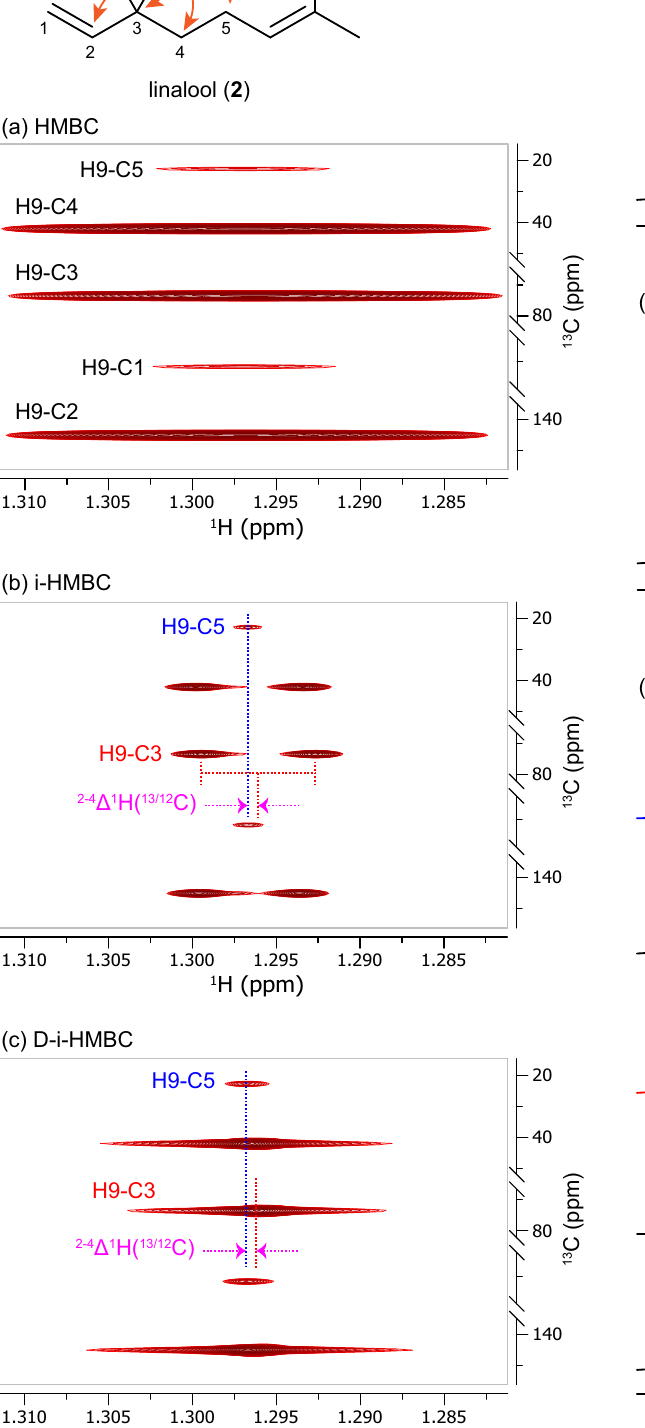
shift ( d ) peak picking, ( e ) line fi tting (blue: fi tted peak; pink: sum of fi tted peak; red: fi tting residue); f stack of horizontal slices of i-HMBC correlations from H9, showing measurements of isotope shift